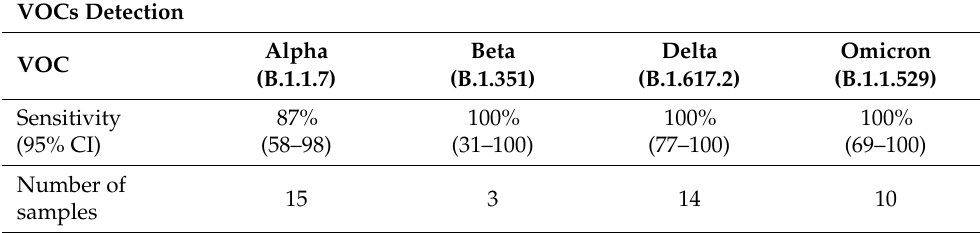
Table 2. VOCs detection with the RT-RPA